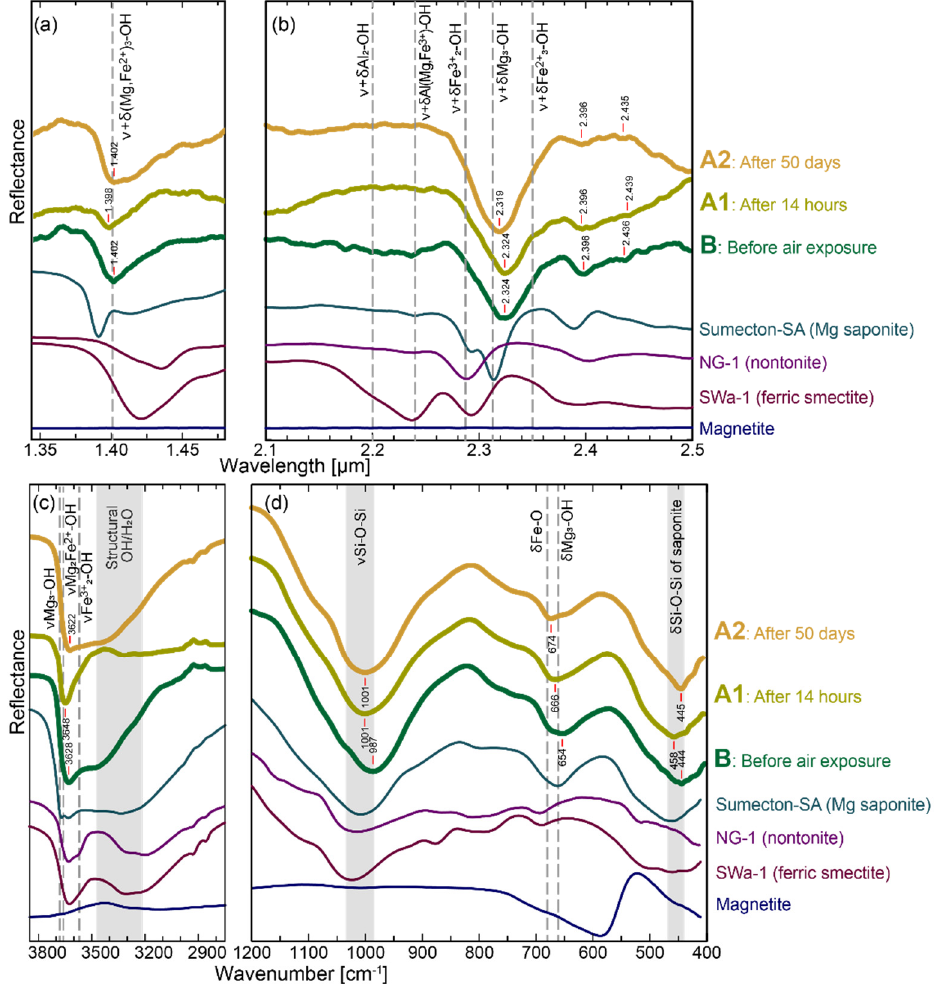
Figure 4. Results of NIR ( a , b ) and MIR ( c , d ) diffuse reflectance spectra of ferrous saponite before (spectrum B) and after air exposure for 14 h (spectrum A1) and 50 days (spectrum A2). The spectra of 4 reference samples are included for comparison. The spectra were scaled and offset after being smoothed for clarity. The numbers with red marks show the centers of the wavelength/wavenumber of absorptions. The gray vertical dashed lines and solid bars show the positions of sharp and broad absorption features, respectively, attributed to the vibrations (see the main text for details).